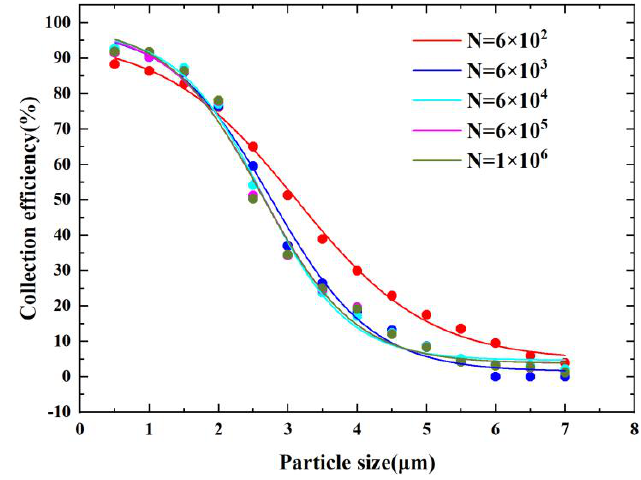
Figure 2. Grid irrelevance verification.